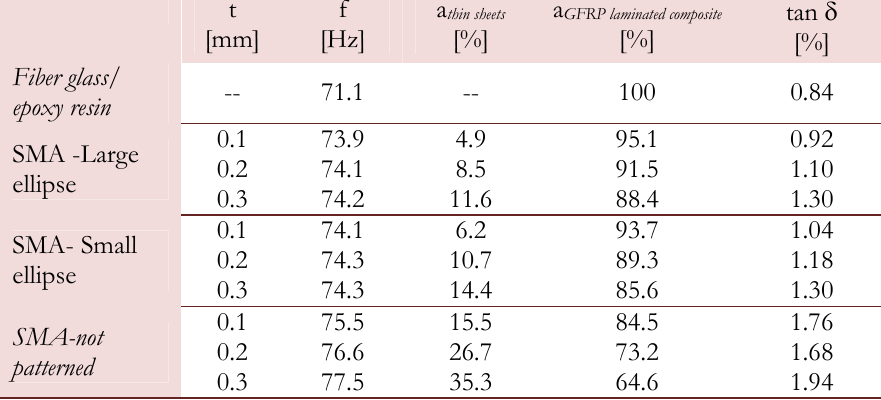
Table 3: FEM analysis estimated loss factor of the hybrid composite with Ni 40 Ti 50 Cu 10 thin sheets